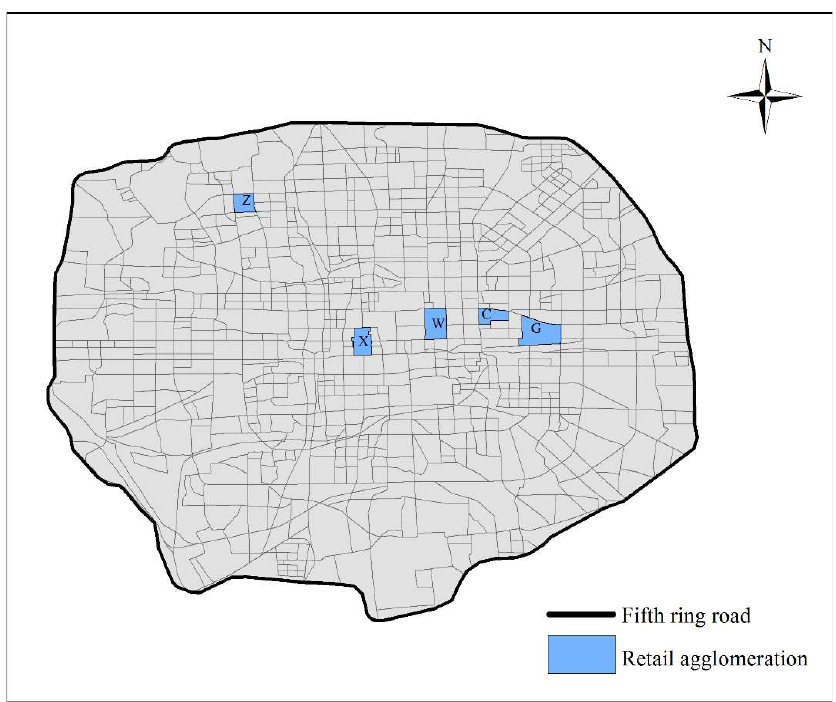
Figure 1. Study area and the distribution of the retail agglomerations.